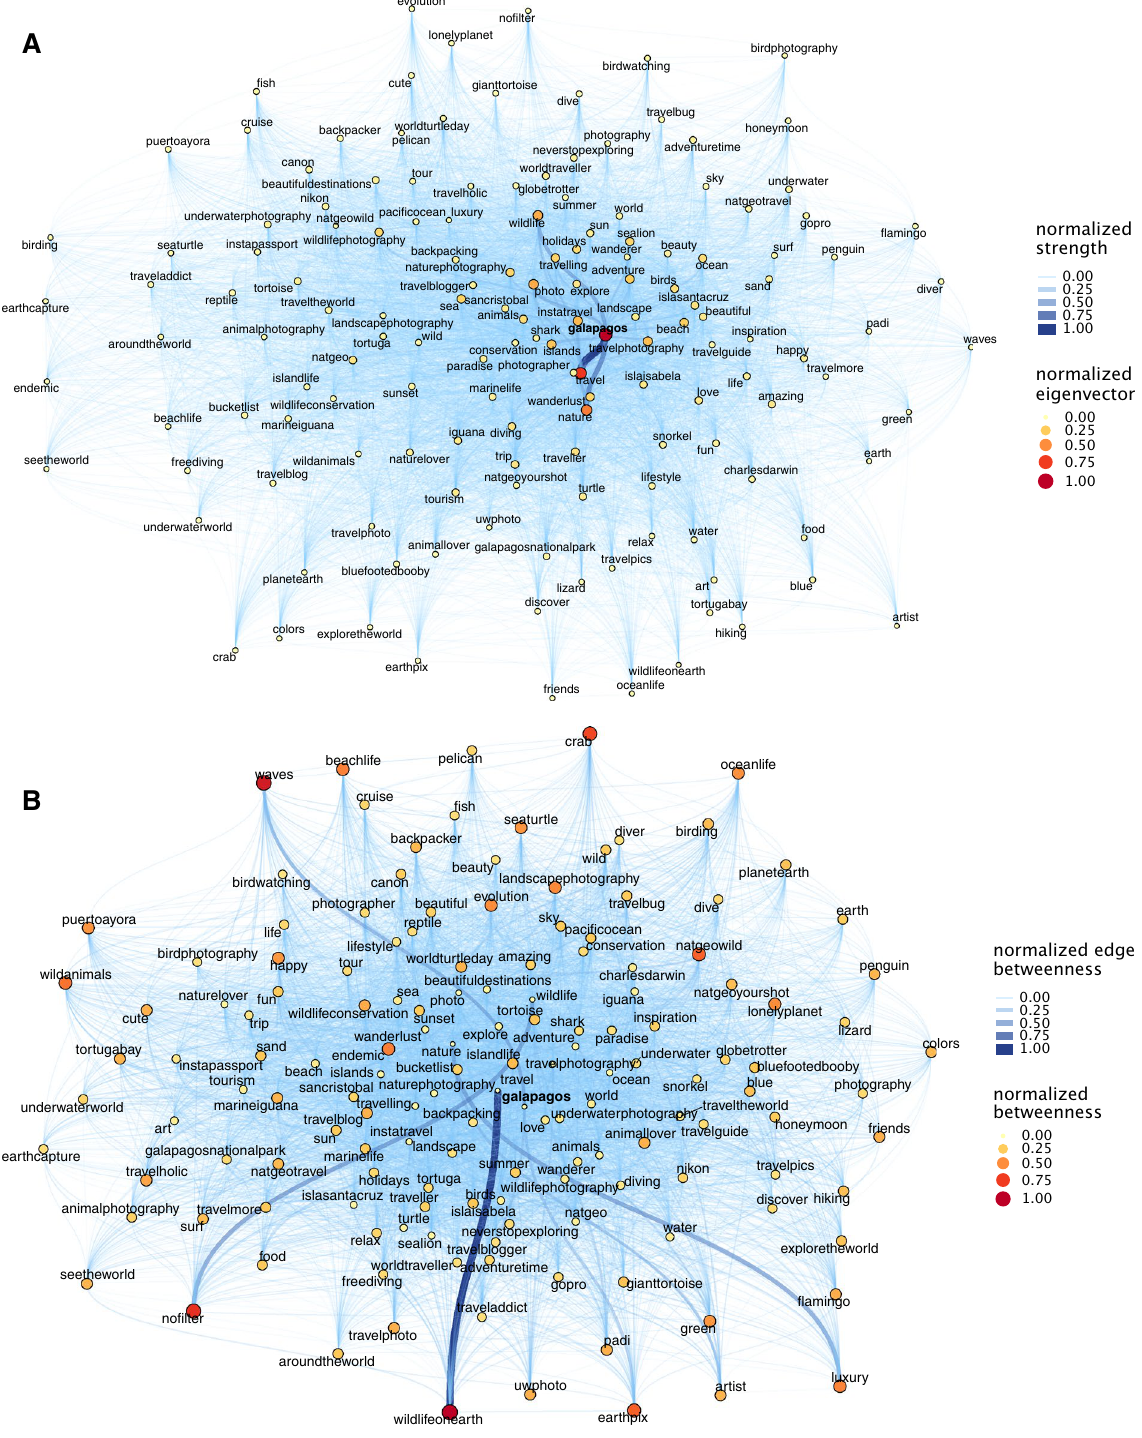
Figure 2. Example of network graphs in Galapagos case study. In plot ( A ) node size represents the Eigenvector centrality and edges represent normalized strength (weighted degree). In plot ( B ) node size represents normalized Betweenness centrality and edges represent normalized Edge